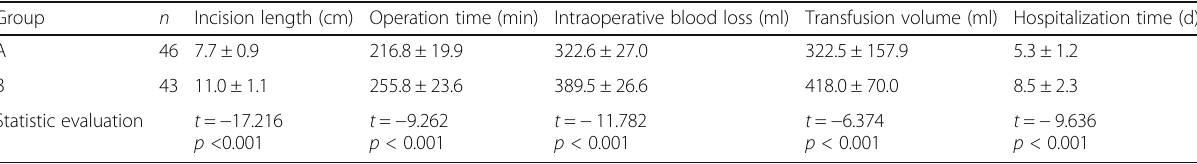
Table 4 Comparison of clinical indexes between 2 groups ð x (cid:3) s Þ Group